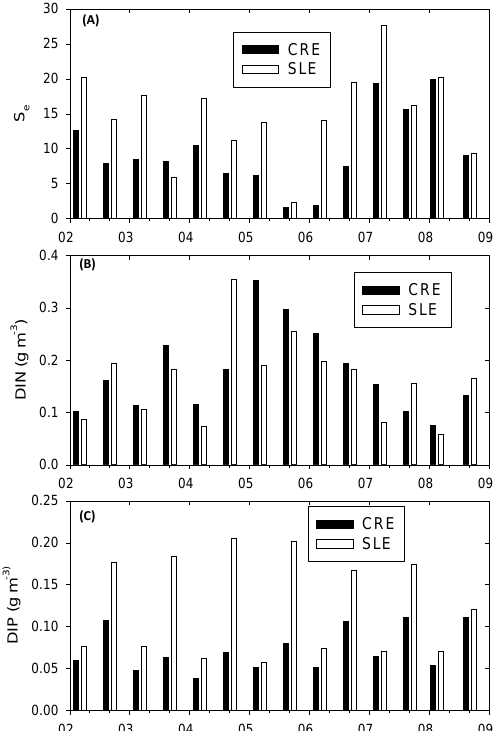
Fig. 4. Comparative seasonal time series of water budget compo- nents for CRE and SLE. CRE (filled) and SLE (open) bars are paired seasonally with the first pair of each year representing the dry sea- son. (A) Salinity; (B) DIN (gm − 3 ) ; (C) DIP (g m − 3 )